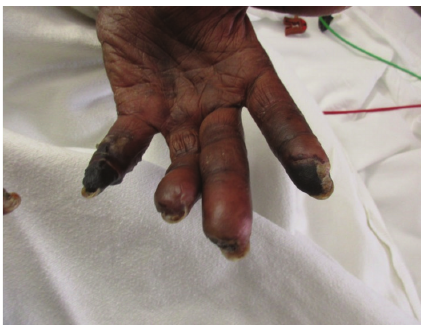
Figure 1: Left hand on admission.